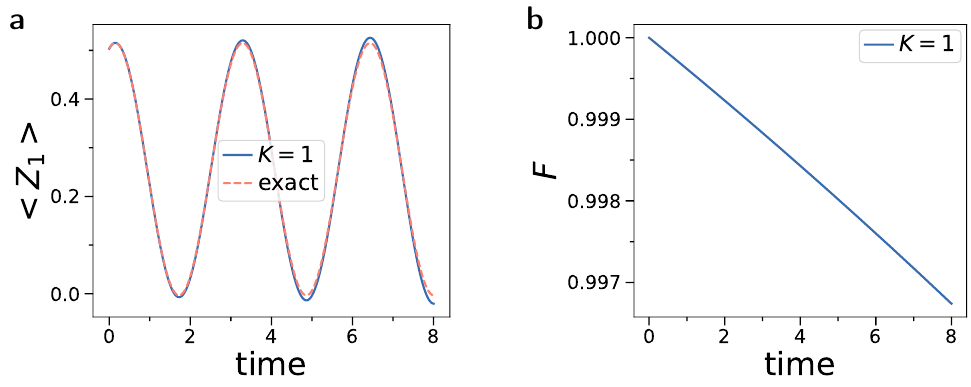
Figure 1: Time evolution of TQS on a 2 qubit state, with Hamiltonian H on the IBM quantum processor ibmq_rome . a) Expectation value of 〈 Z of the state.